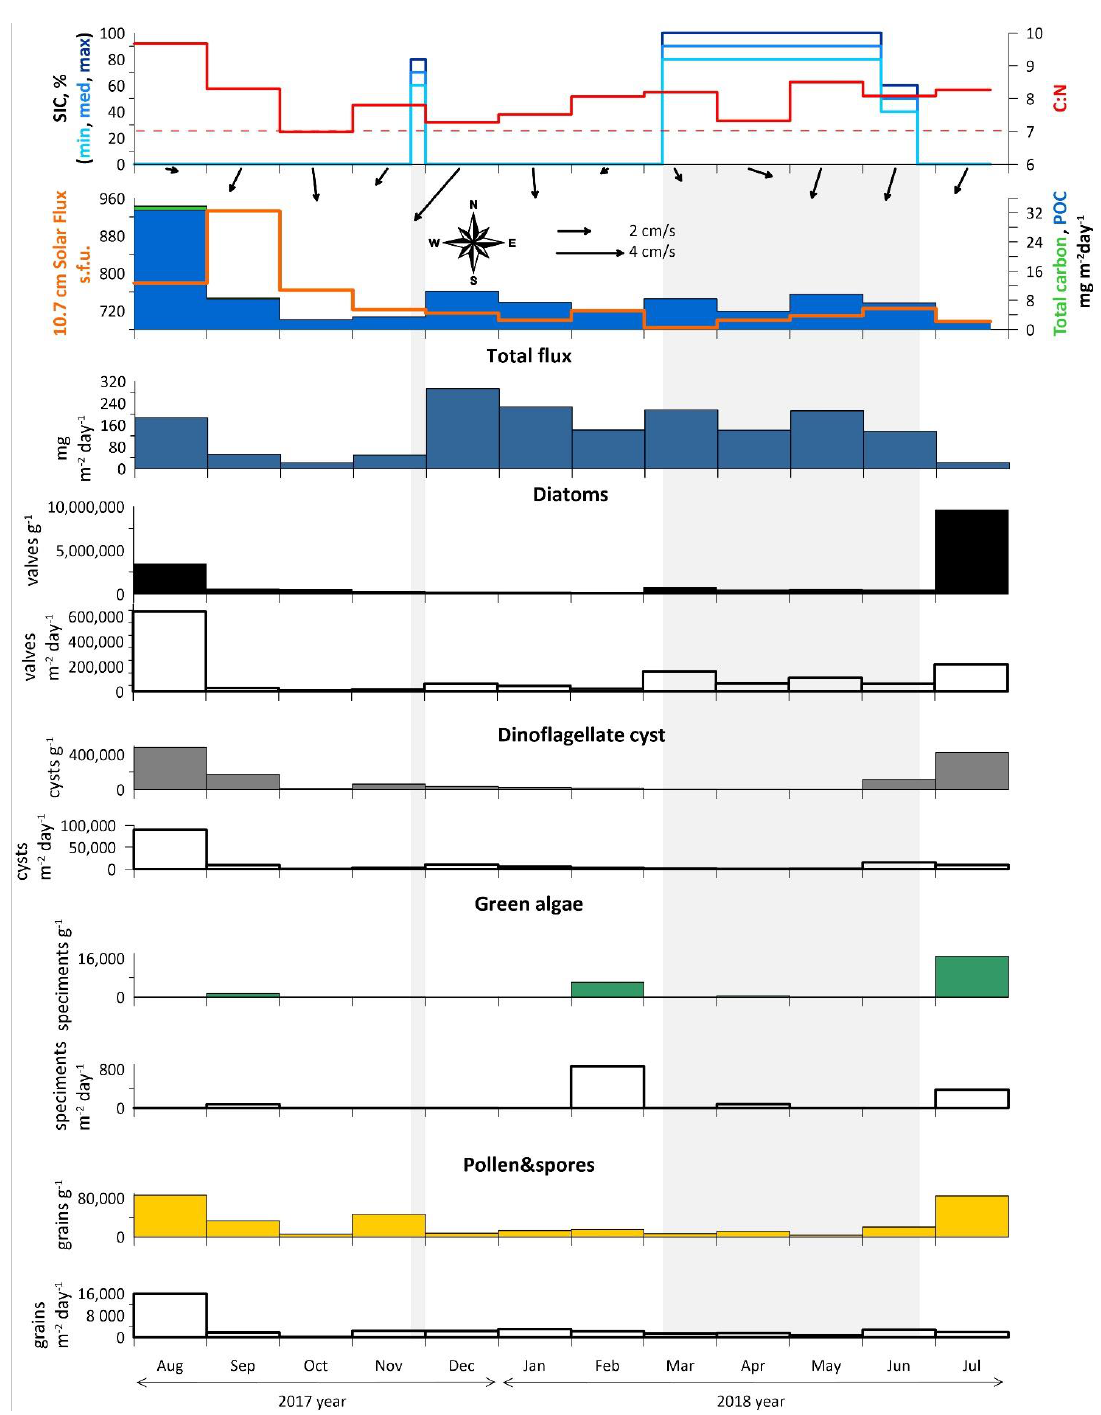
Figure 3. Annual data from AMK-5565 ADOS: Sea-ice cover (concentration in %), C:N and monthly averaged current vectors; particulate organic carbon (POC) and solar flux; total mass flux; overall concentrations (filled silhouettes) and fluxes (empty silhouettes) of diatoms, dinoflagellate cysts, green algae, pollen and spores. Light gray rectangles mark the ice-covered season (SIC > 50%).